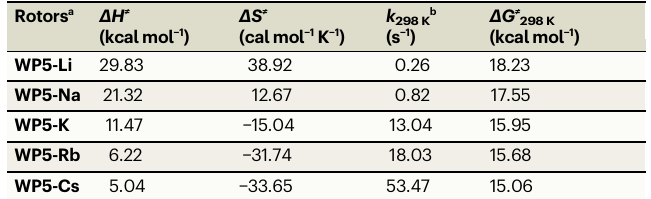
Table 1 | The summery of kinetic parameters of WP5-M in D 2